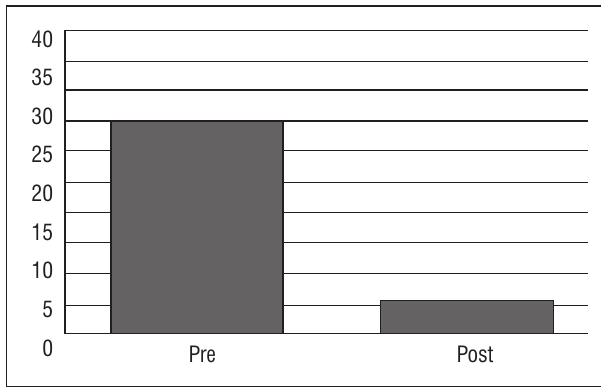
Figure 4 - Comparison of the initial with the final score of the NPDS questionnaire, showing decrease of the physical disability (p < 0.001